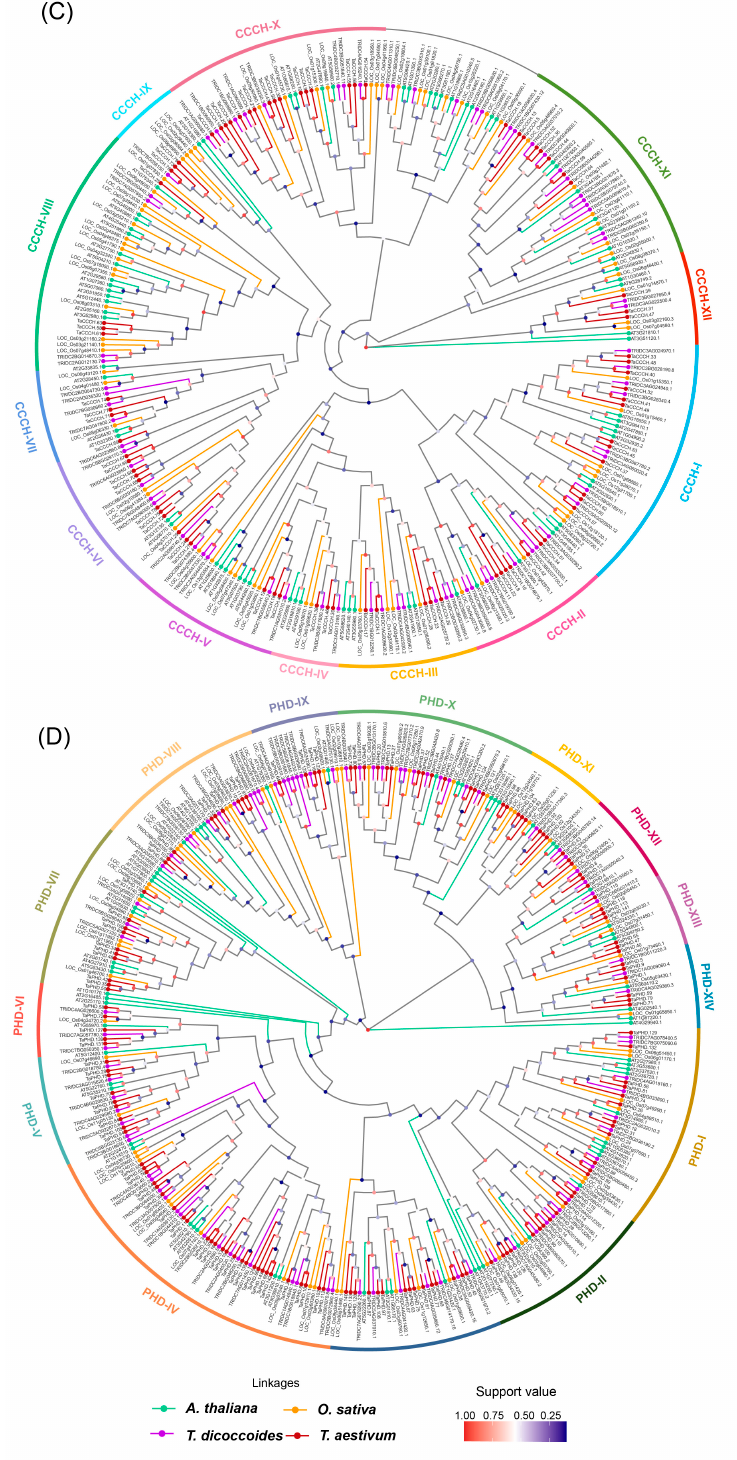
Figure 2. Phylogenetic trees of ZFP subfamily genes in T. aestivum , T. dicoccoides , O. sativa , and A. thaliana . ( A ) C2H2. ( B ) C3HC4. ( C ) CCCH. ( D ) PHD. Each identified subgroup is marked with Roman numerals near the branch. The different colours on the terminal branches represent ZFP genes from different species. The colours of nodes are a mapping of support values from 1000 SH